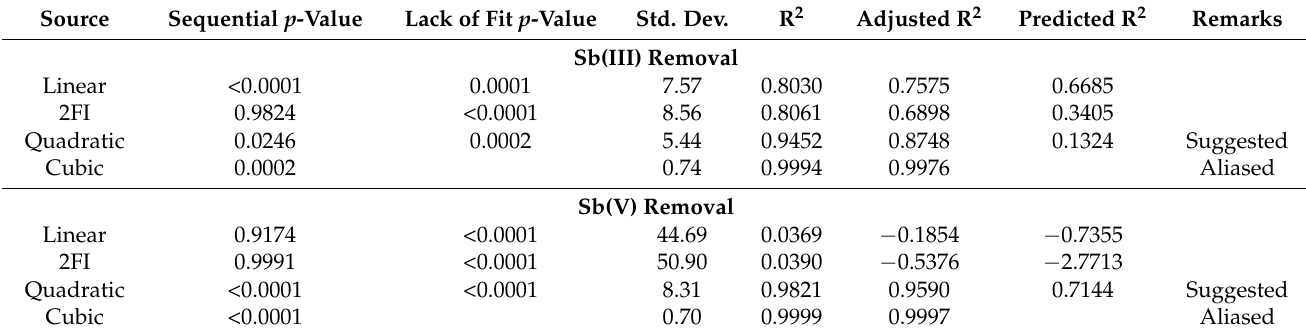
Table 5. Model summary statistics for response variables investigated.